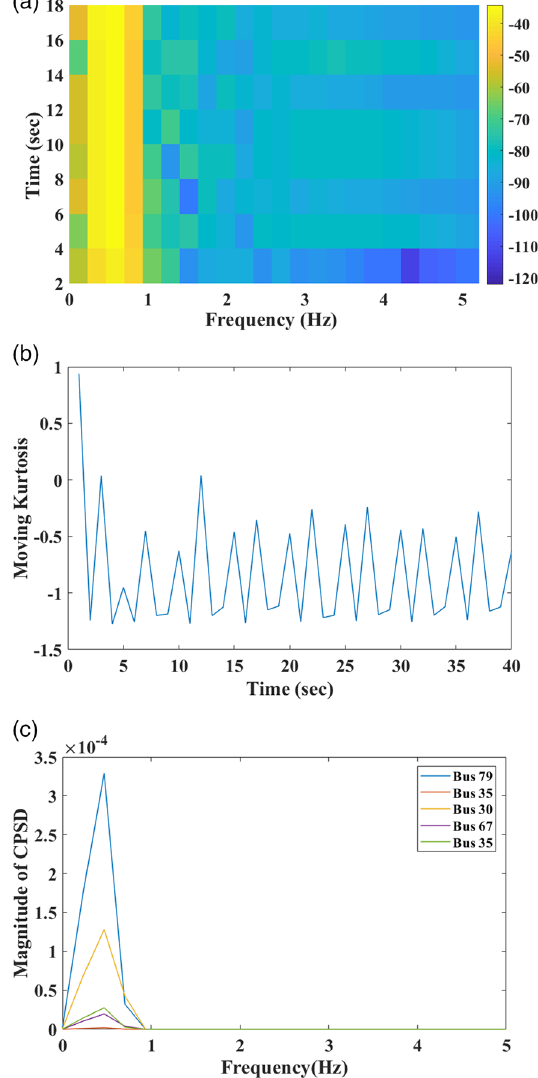
Fig. 8 a PSD of the selected DMAP. b Excess kurtosis. c Magnitude of CPSD between the selected DMAP and raw PMU data from different buses associated with generation